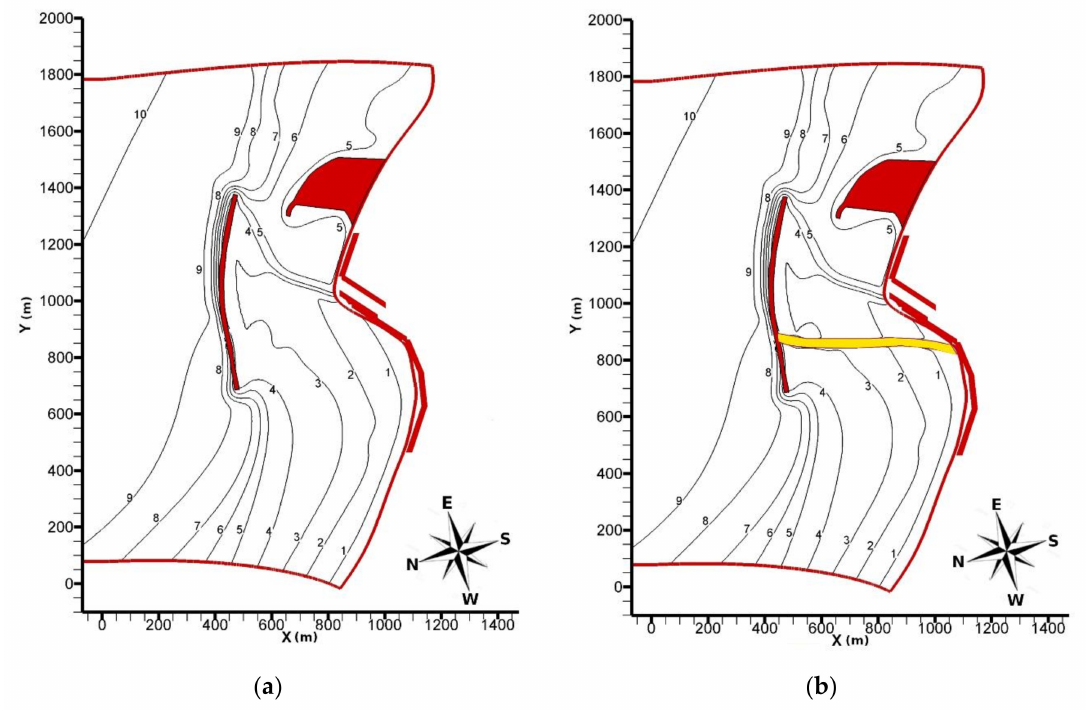
Figure 4. Plan view of Pescara Harbour and the still water depth measured from mean water level: ( a ) Configuration 1; and ( b ) Configuration